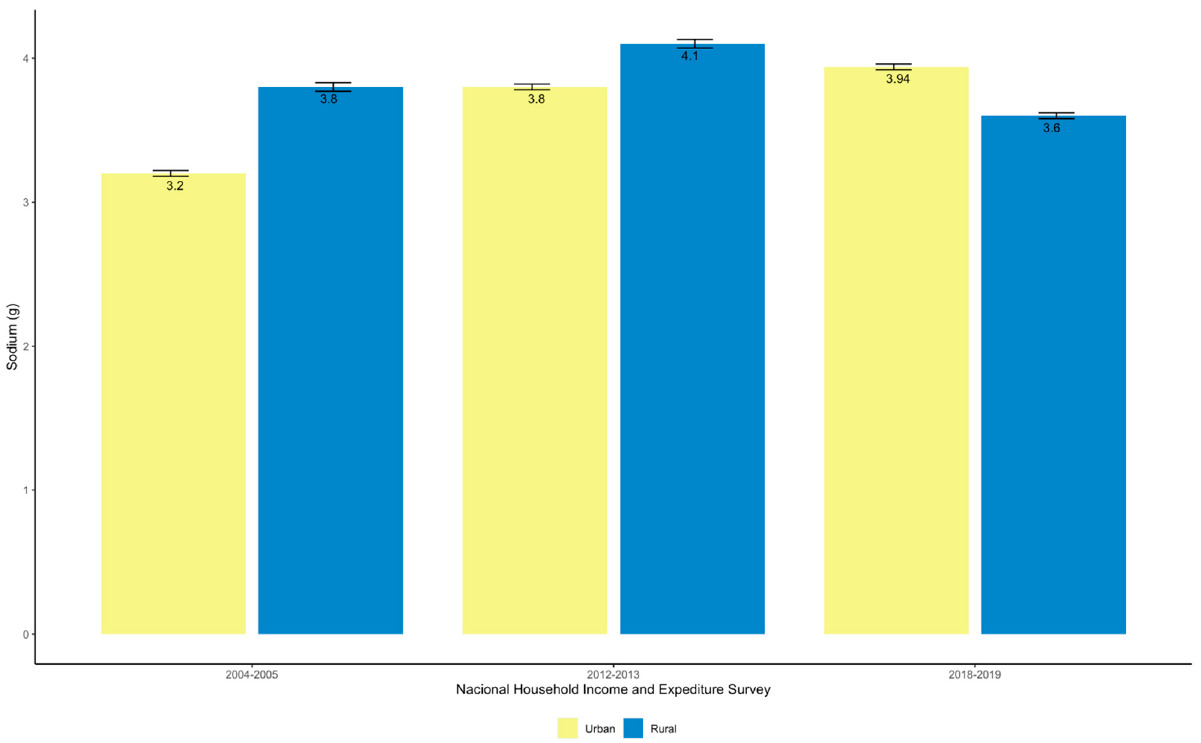
Figure 2. Sodium availability for household consumption according to zone of residence in Costa Rica during 2004–2005, 2012–2013 and 2018–2019 (g/day/person adjusted to 2000 kcal/day).